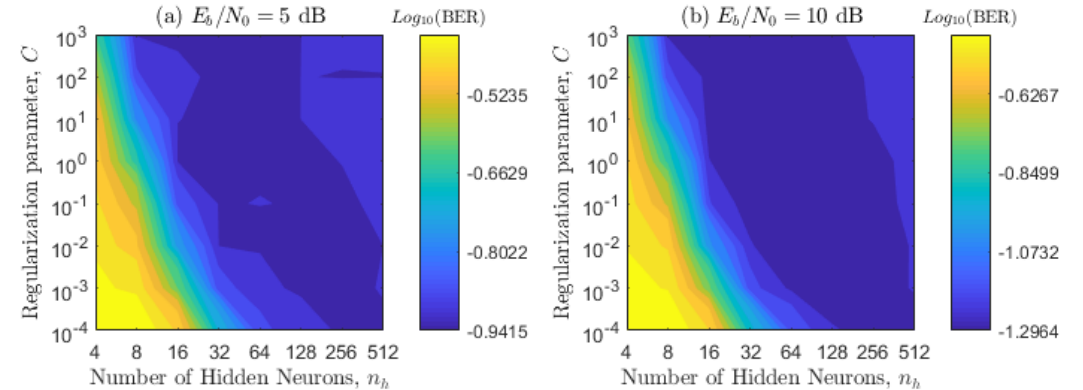
Figure 8. BER countour plot in terms of the regularization parameter C , number of hidden neurons, and different E b / N 0 values for system configuration 1.